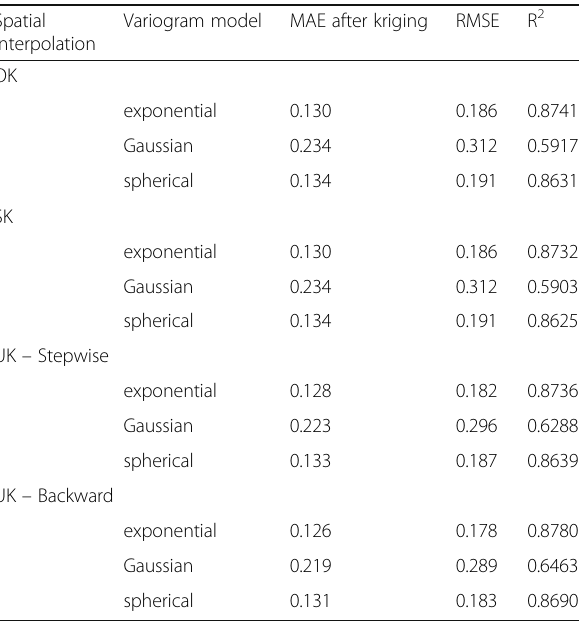
Table 5 Cross validation of OK, SK, and UK applying exponential, Gaussian, and spherical variogram models applied to Clay texture fraction Spatial